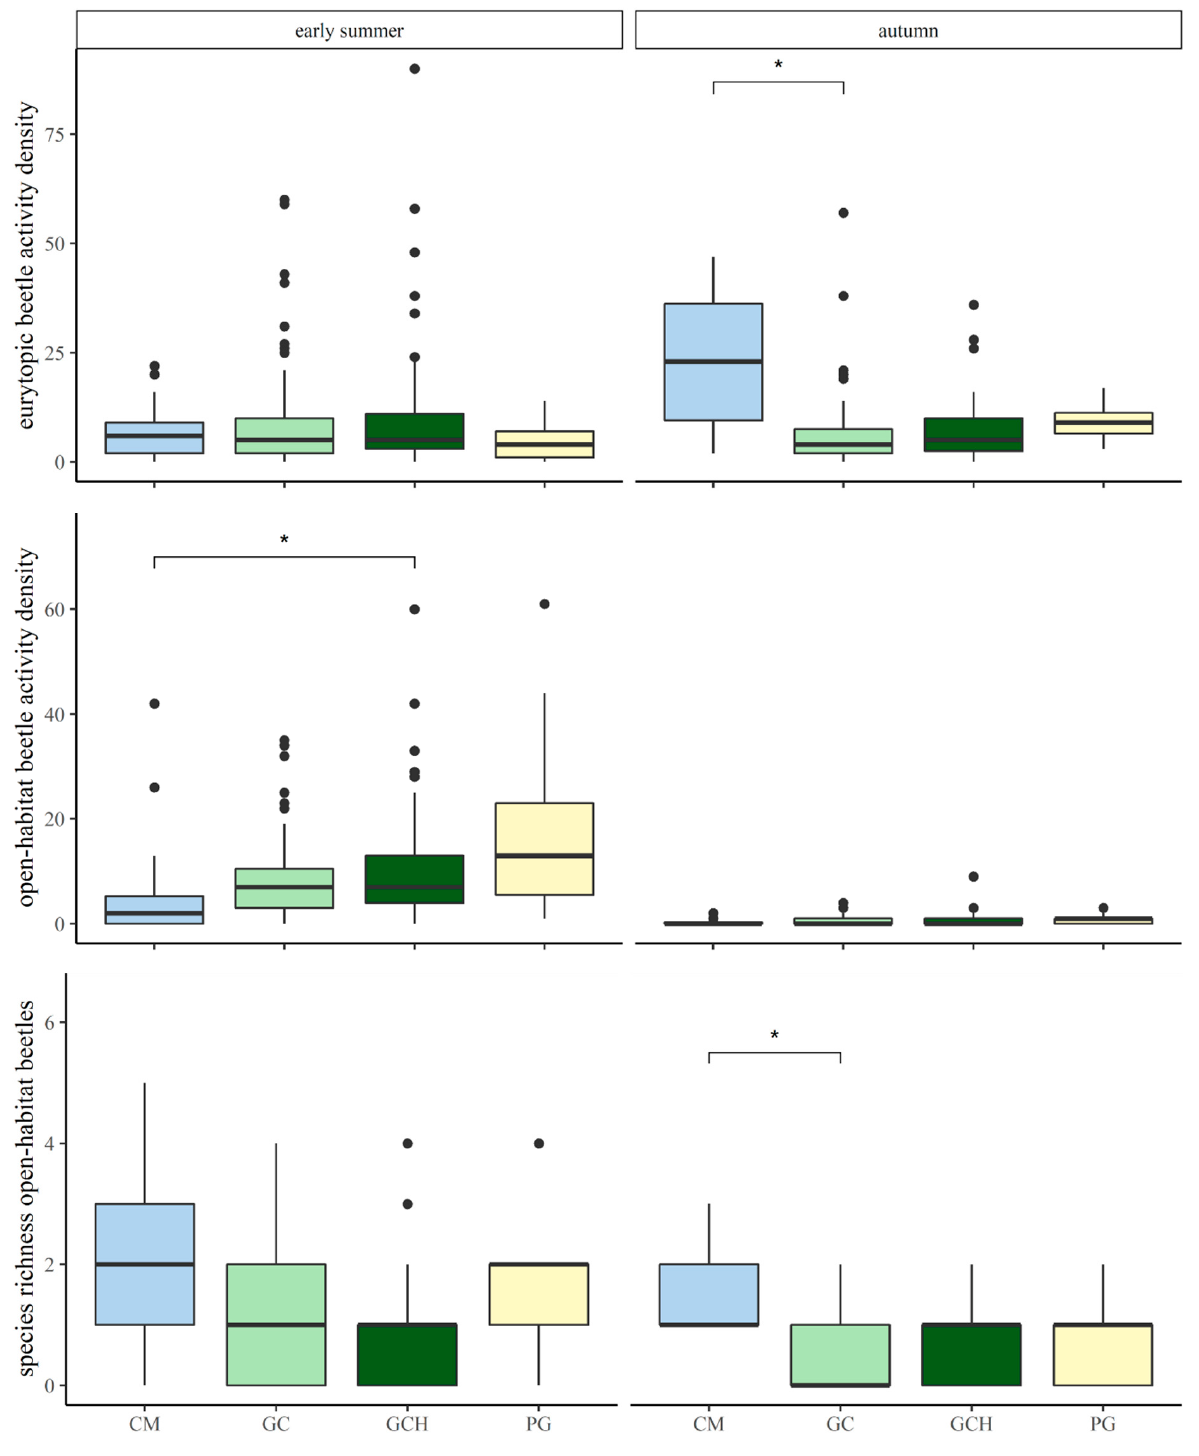
Figure 4. Beetle activity densities of eurytopic and open-habitat beetles, and species richness of open-habitat beetles of organic grass–clover (GC) and organic grass–clover herbs (GCH) in comparison to conventional maize (CM) and organic permanent grasslands (PG) in early summer and in autumn. p -values are indicated as * p < 0.05.